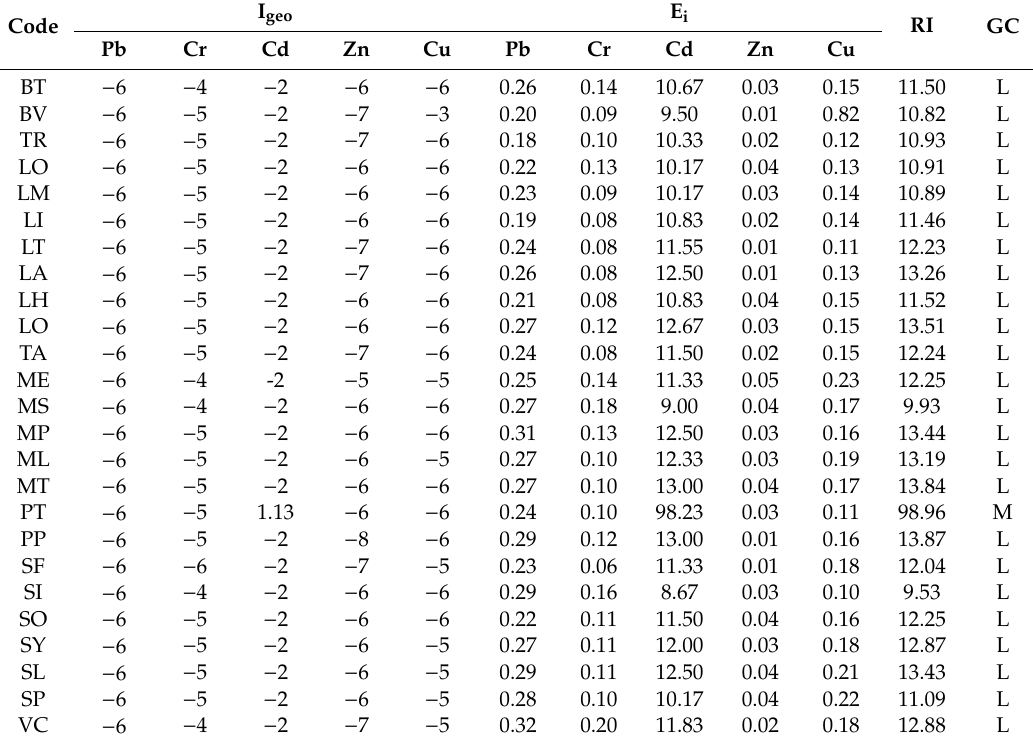
Table 4. Results of the geoaccumulation index (I geo ), ecological risk factor (E i ), and potential ecological risk index (RI) for each study site in the Sotavento